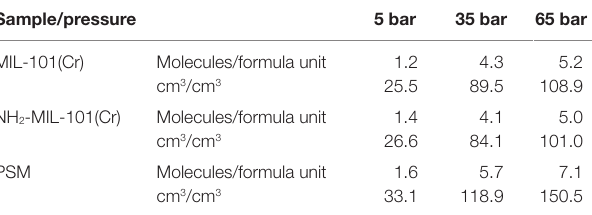
TaBle 1 | adsorbed ch 4 at 5, 35, and 65